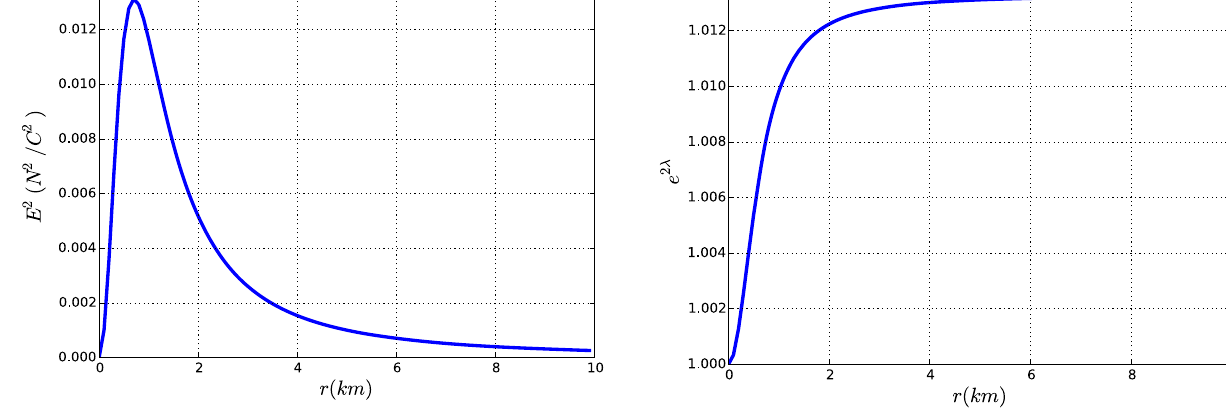
Fig. 3 Electric field E 2 against radial distance r